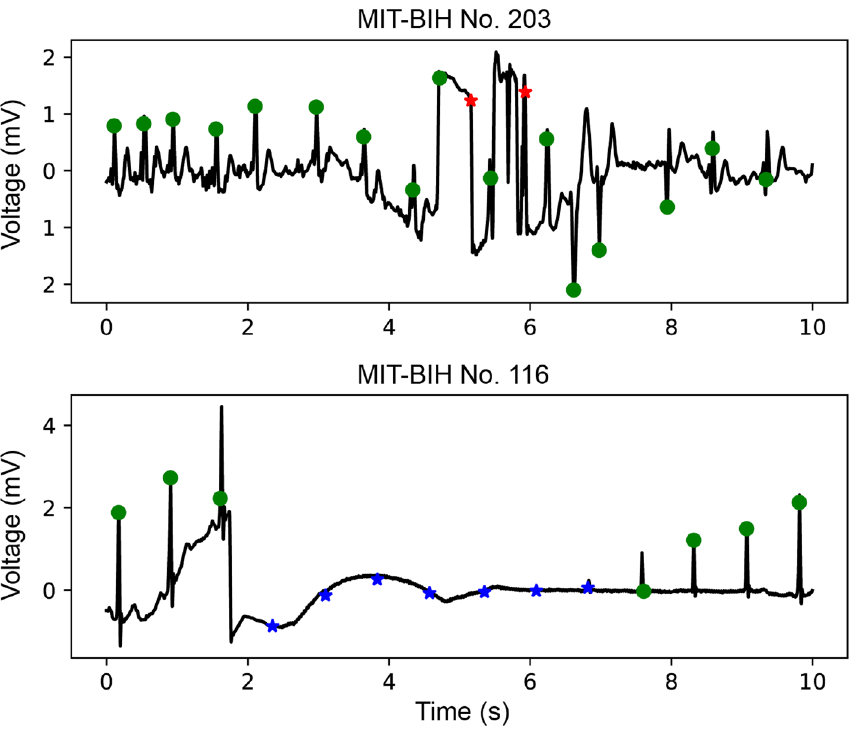
Figure 5. Examples of false predictions from model in MIT-BIH